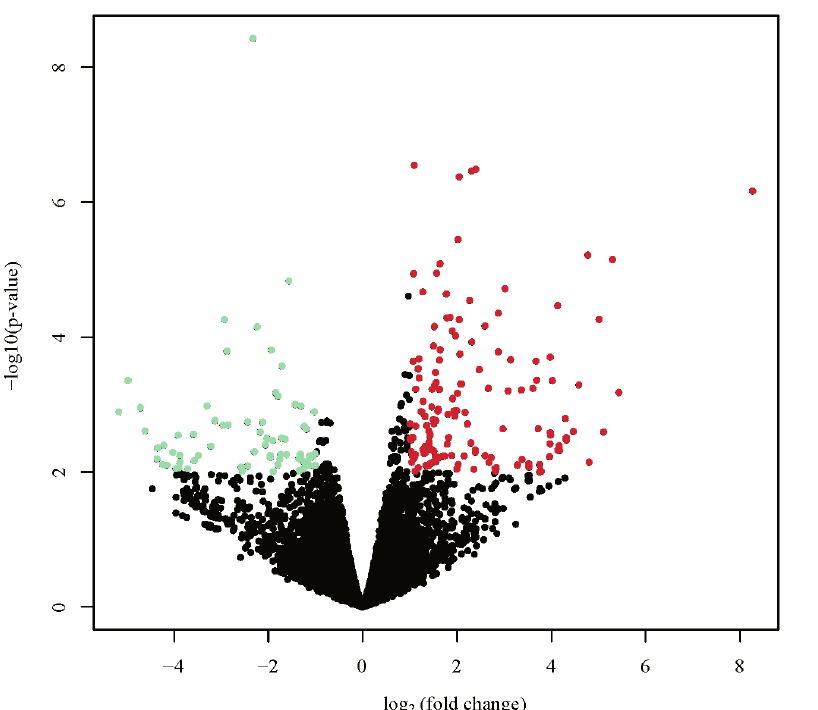
Figure 2. Volcano plot appearing p-values against fold changes. The volcano plot reports log (p-value) for genes as Y variables plotted against their respective log (fold change) as X variables. The red and green dots indicated significantly up- and down-regulated in dark brown eggshell 2 (DBE) group vs. light brown eggshell (LBE) group, respectively (p<0.01, |log fold change| >2). The black dots represent no differential expressed 2 genes (DEGs).